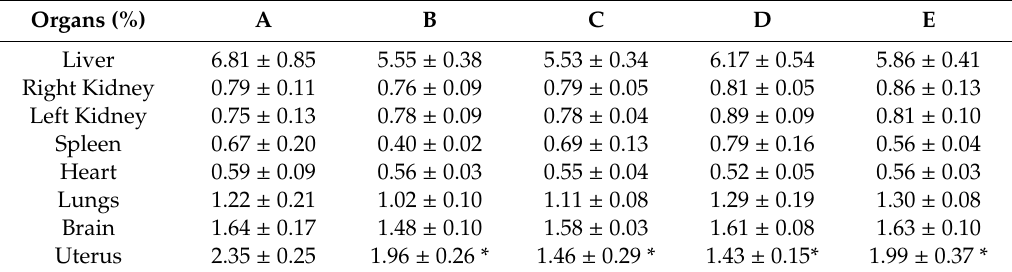
Table 7. Relative organ weights in % (mean ± SEM) of female ICR mice in subacute toxicity study of CELE.